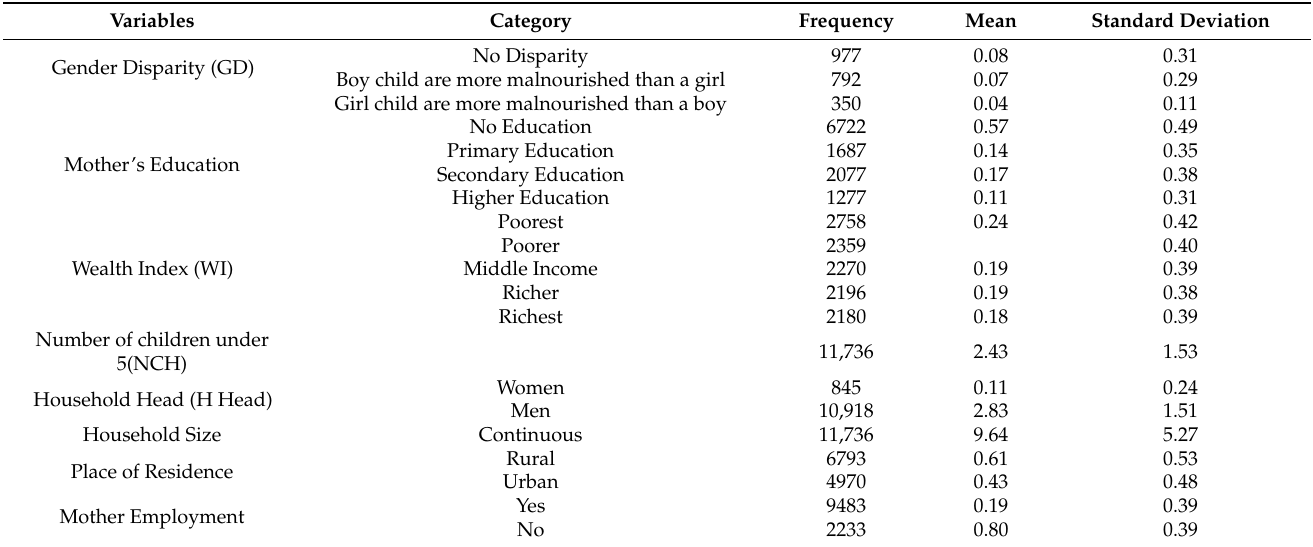
Table 2. Descriptive statistics of